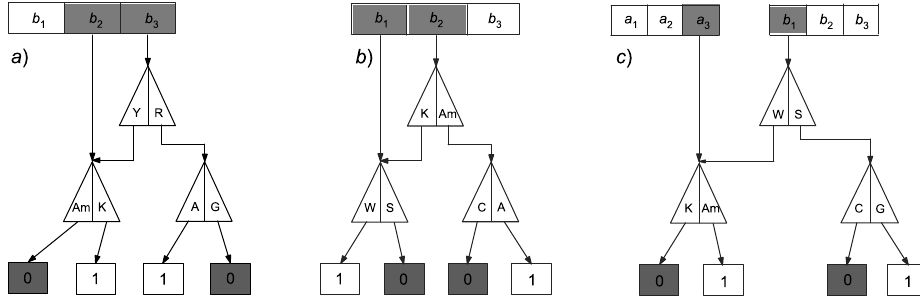
Figure 3 – Algorithmic representation of the dichotomic classes: a ) parity class, b ) Rumer’s class, c ) hidden